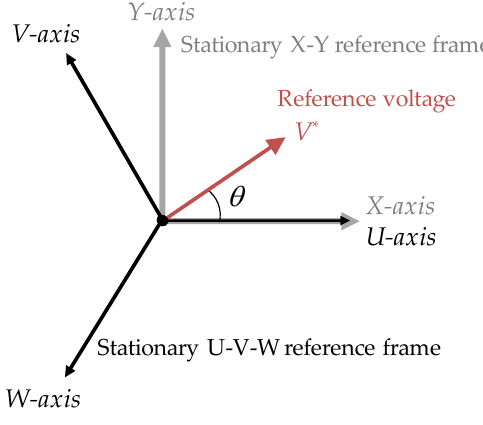
Figure 8. Reference voltage and stationary reference frame.